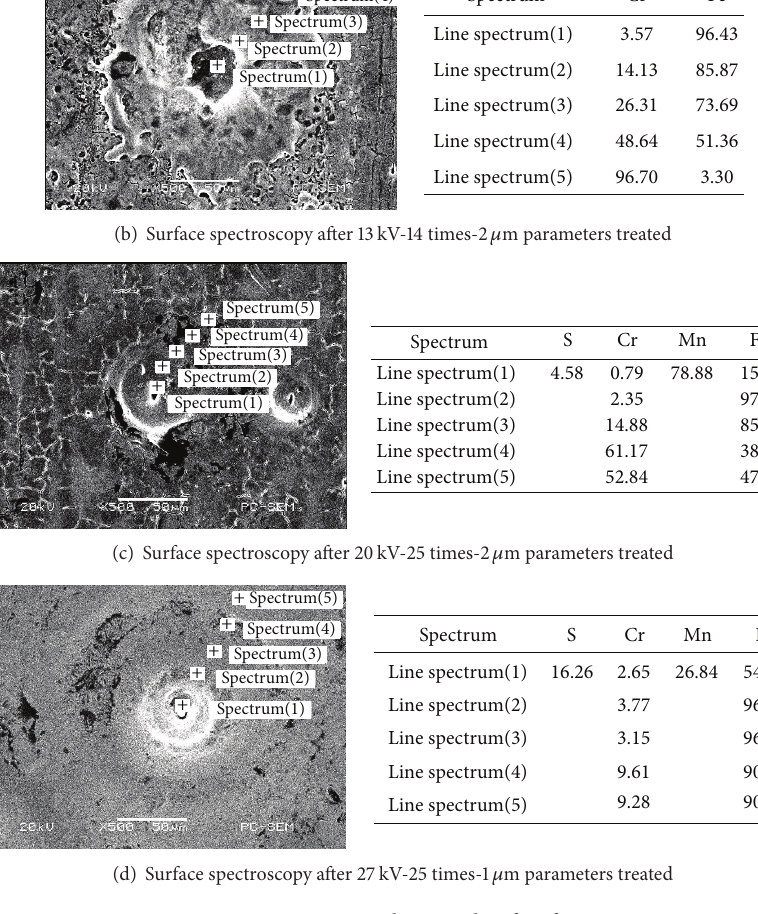
Figure 2: Spectroscopy analysis results of surface